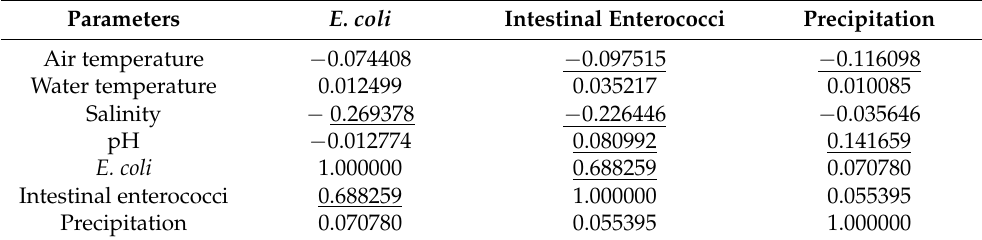
values for the 2021 bathing season (Tables S2 and S3). Table 2. Spearman’s correlation coefficients between the examined variables for both bathing seasons. Statistically significant correlations ( p < 0.05) are underlined.